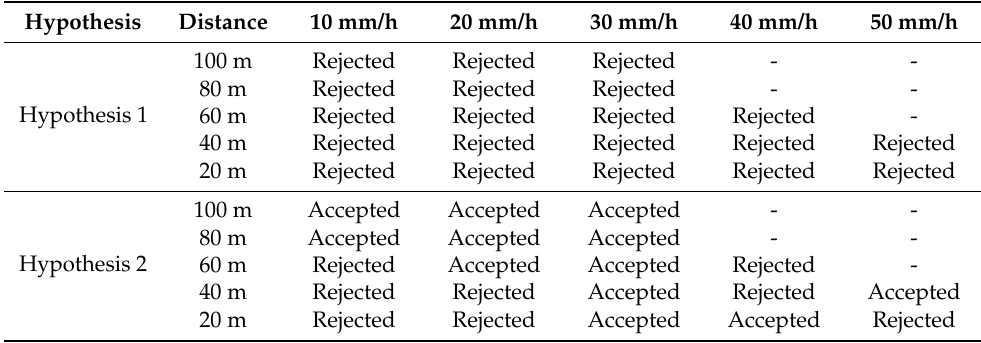
Figure 10. Average of intensity with speed for each distance and for each material for different amounts of rainfall. Table 8. Results of ANOVA test on the effect of target materials and speed on the intensity for each distance and for different amounts of